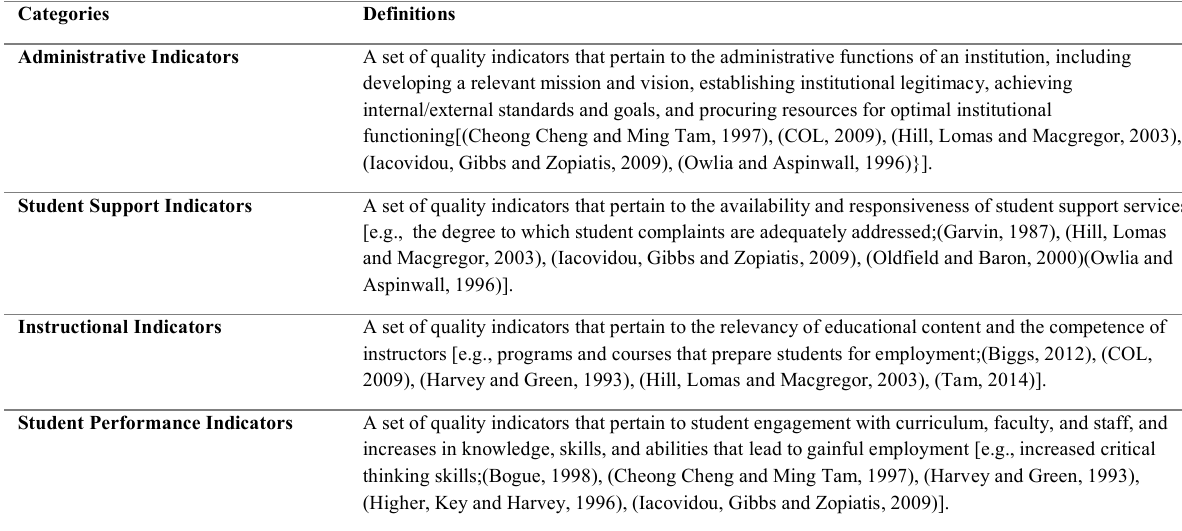
Table 1: Categories of Quality